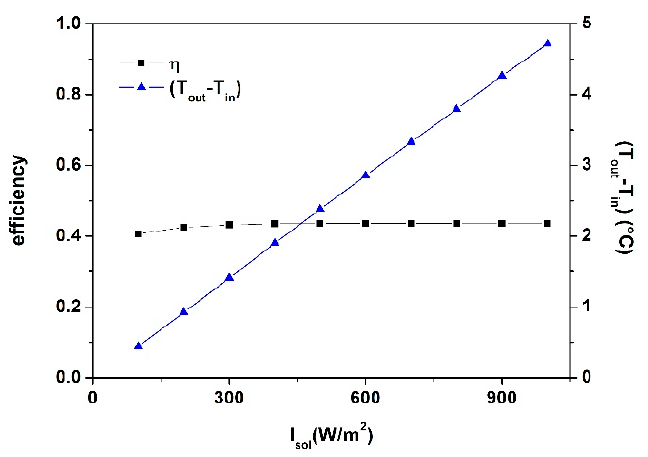
Figure 12. Results of the parametric study. E ffi ciency and temperature di ff erence vs. solar irradiation.